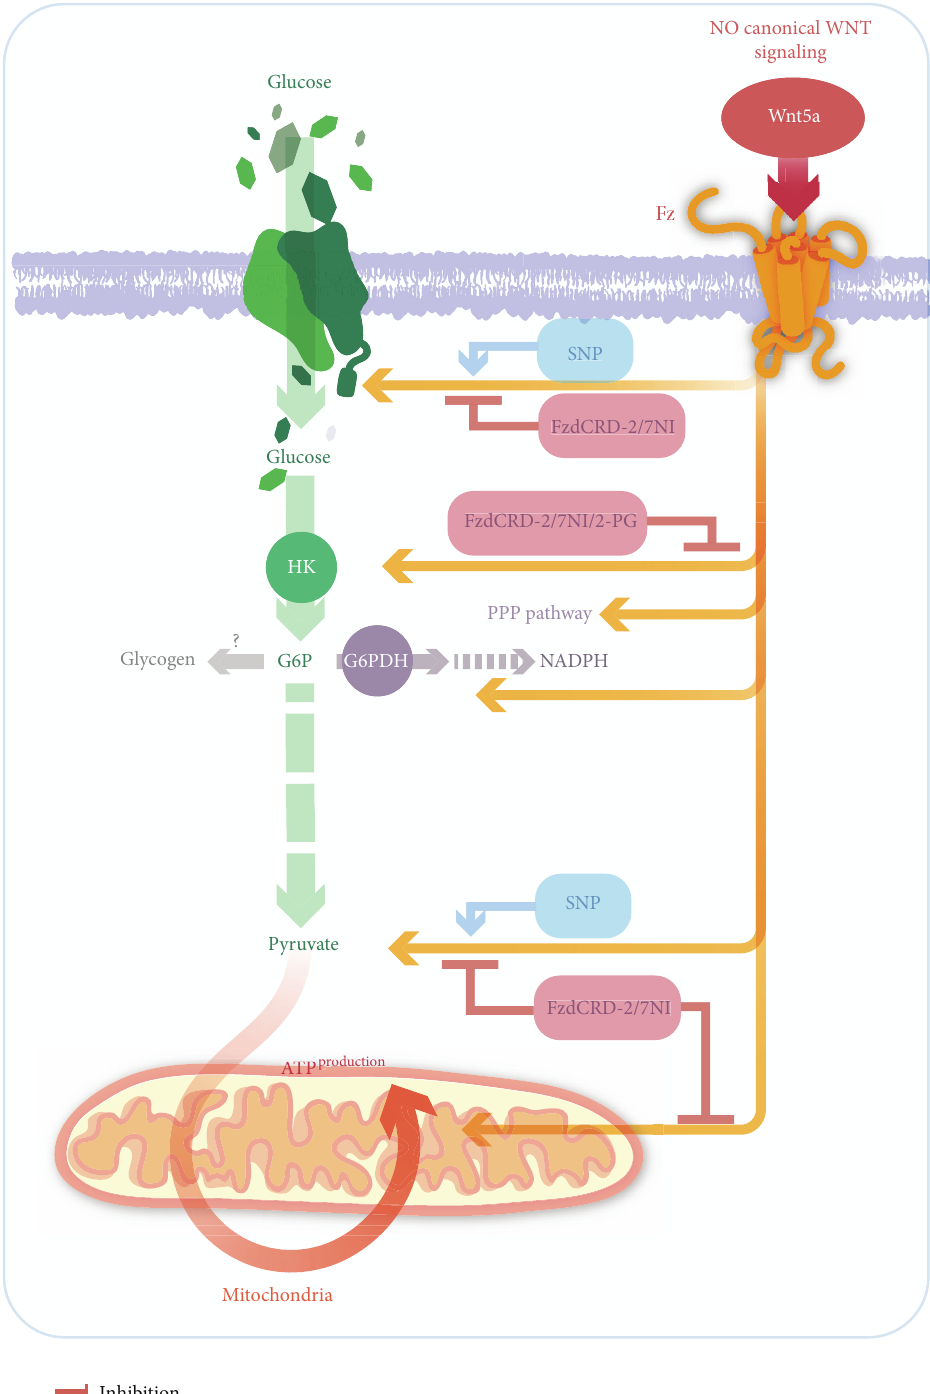
Figure 5: Schematic representation of the effect of Wnt5a over the glucose metabolism in cortical neurons. The Wnt5 stimulates the glucose uptake and the activity of the HK. Downstream the Wnt5a stimulates the glycolytic rate and PPP activity, in a NO-dependent manner. The increaseintheglycolyticratewascorrelatedwithanincreaseinthegenerationofATP.TheincreaseinthePPPactivity(throughtheproduction